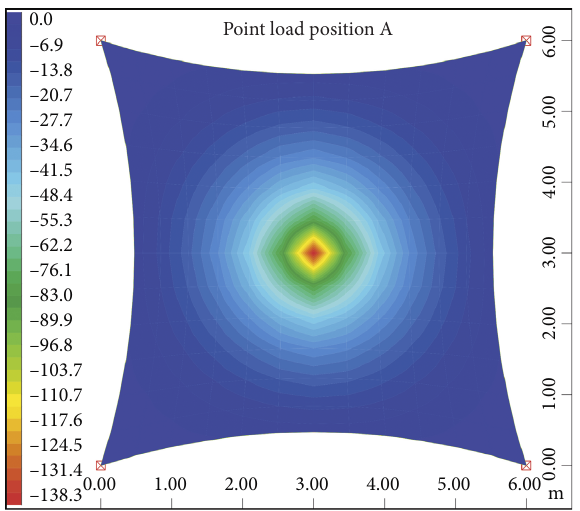
Figure 3: Membrane deflections of the initial model in global Z direction for 1 kN point load acting in position A